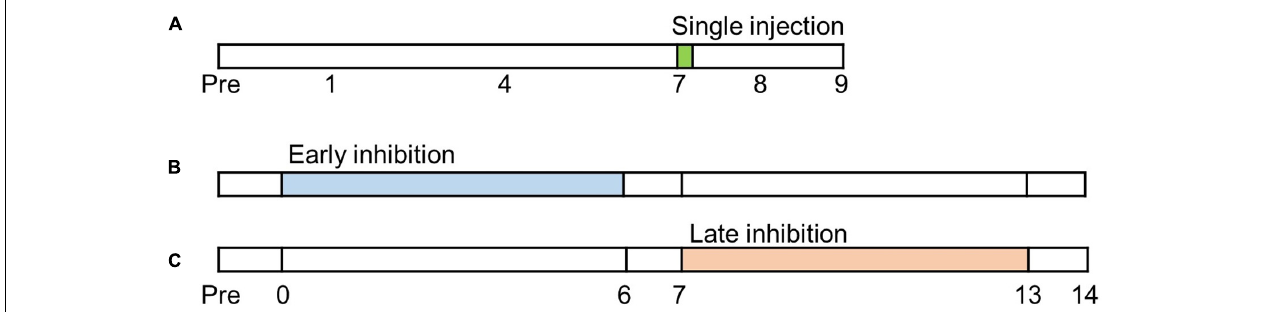
FIGURE 1 | Timetable of experiments. Before neuropathic pain (NP) surgery (post-injury day, PID, 0), cannula implantations were performed. (A) Single injection experiment. Glial inhibitors were only injected once on PID7. (B) Early inhibition experiment. After NP surgery, the glial inhibitors were repetitively injected from PID0 to PID6. (C) Late inhibition experiment. Glial inhibitors were administered on PID7 and continued until